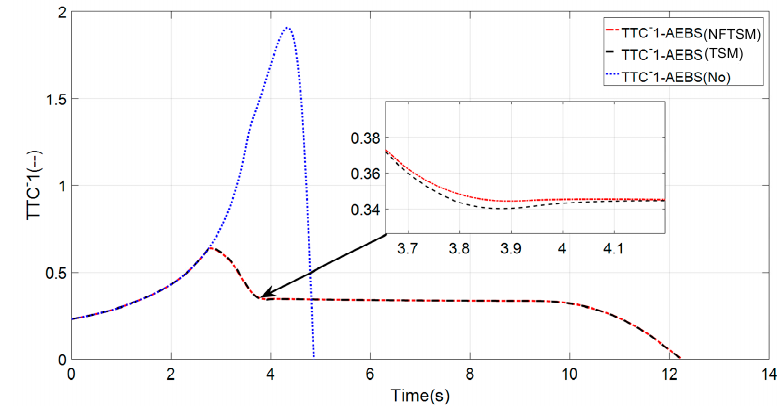
Figure 14. Comparison of vehicle acceleration.